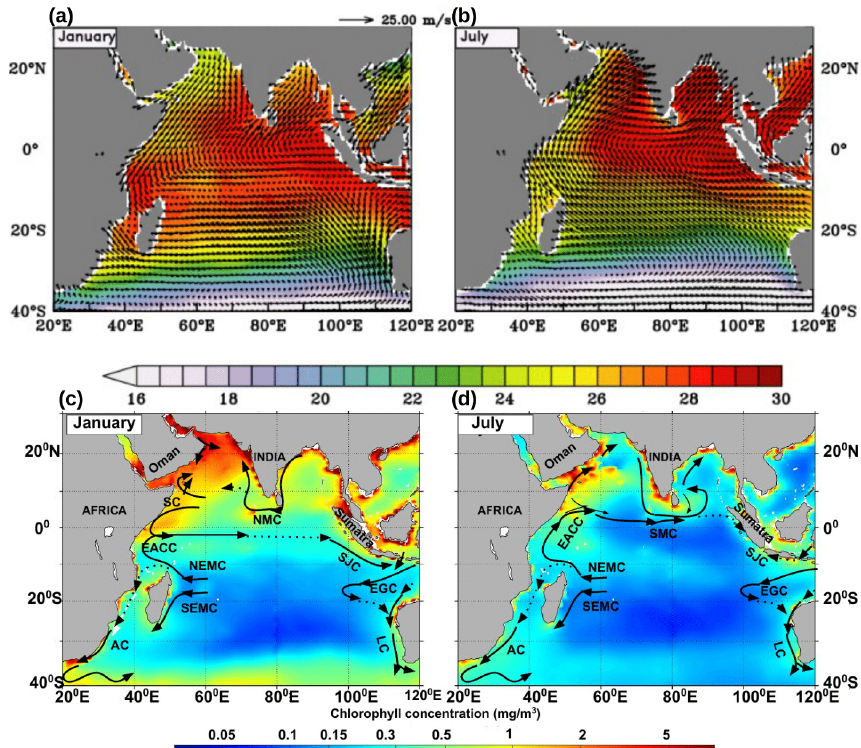
Figure 1. Upper panels show climatological (Locarnini, 2018) sea surface temperature (SST) averaged from surface to 50m depth (shaded) and NASA Quick Scatterometer (QuikSCAT) (http://apdrc.soest.hawaii.edu./, last access: 3 November 2021) winds (vectors ms − 1 ) , for the months of (a) January and (b) July. The colour scale for SST is given below the panels, and the scale vector for wind speed is given at the top. Lower panels show a schematic representation of the major current systems (modified after Schott et al., 2009) in the Indian Ocean for (c) January and (d) July, overlaid on chlorophyll (shaded, mgm − 3 ) climatology. Abbreviations (not all shown in the figure but used throughout) are as follows: Agulhas Current (AC), West India Coastal Current (WICC), East India Coastal Current (EICC), Sri Lanka Dome (SLD), South Equatorial Current (SEC), South Equatorial Countercurrent (SECC), Northeast Madagascar Current and Southeast Madagascar Current (NEMC and SEMC), East African Coastal Current (EACC), Somali Current (SC), Southern Gyre (SG) and Great Whirl (GW), Northeast Monsoon Current (NMC), South Java Current (SJC), Indonesian Throughflow (ITF), East Gyral Current (EGC), Leeuwin Current (LC), and Southwest Monsoon Current (SMC). Chlorophyll data are monthly climatology data from SeaWiFS (http://nomads.gfdl.noaa.gov, last access: 3 November